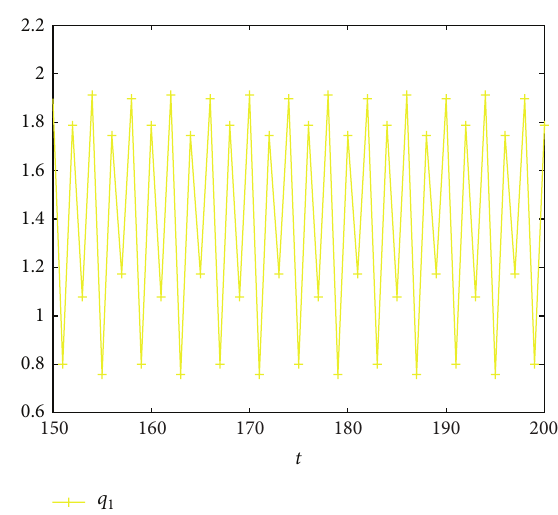
Figure 16: The wave plots of the output 𝑞 1 with the change of time when 𝛼 1 = 1.02 , 𝛼 2 = 1.46 and 𝜃 = 0.843